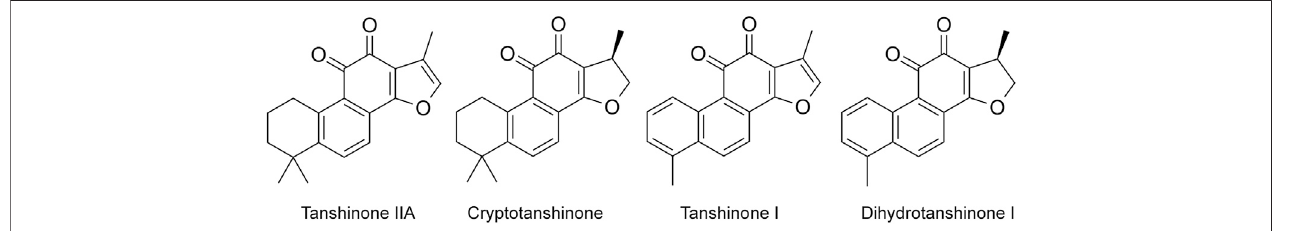
FIGURE 1 | Main fat-soluble components in Salvia miltiorrhiza (Tanshinone IIA, cryptotanshinone, tanshinone I, and dihydrotanshinone